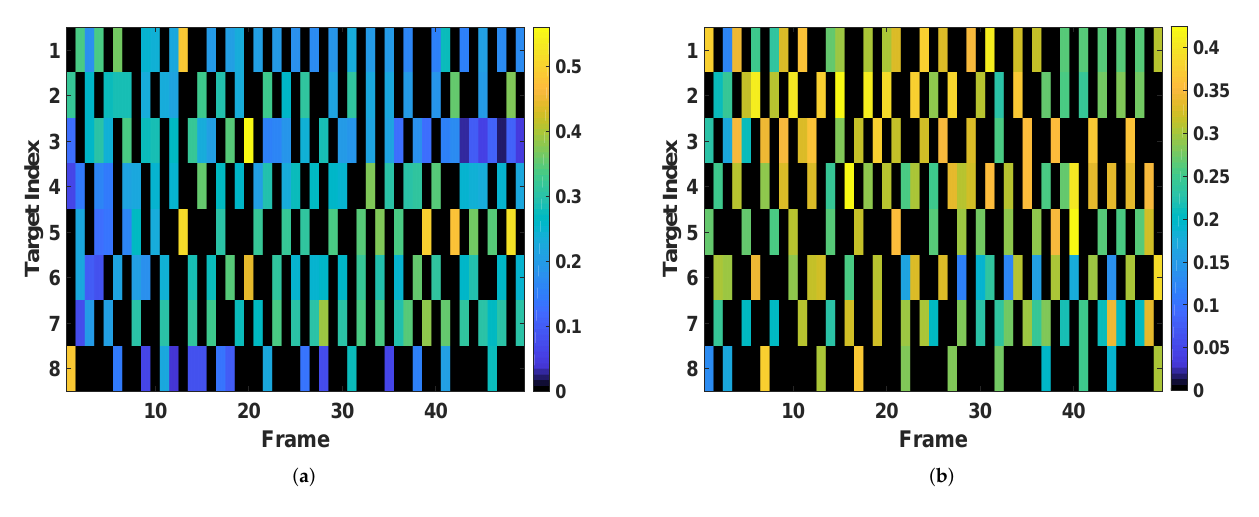
Figure 13. The resource allocation results. ( a ) Proposed power allocation method. ( b ) Optimization- based power allocation